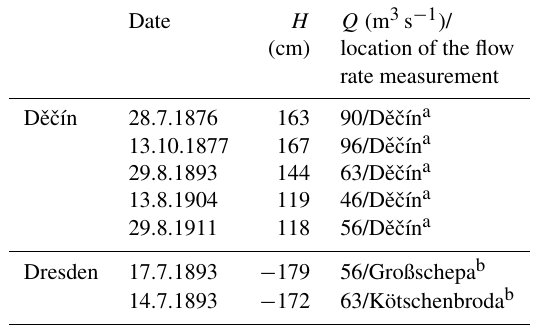
Table 1. The oldest measurements of very low flow rates in Dˇeˇcín and on the Saxon